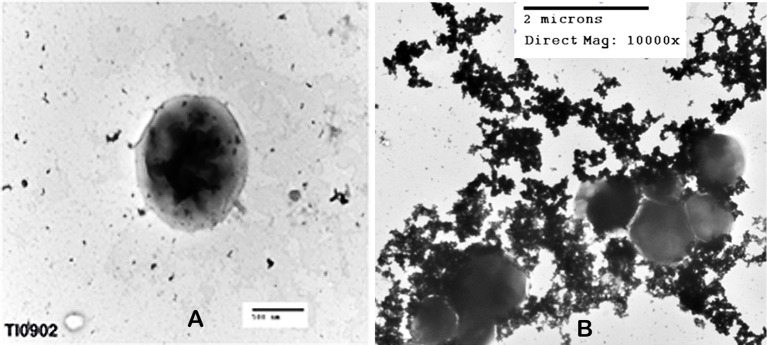
TEM of F. tularensis type A clinical isolate strain TI0902. The bacteria were fixed in glutaraldehyde buffer overnight and stained with 0.5% uranyl acetate. (A) Strain TI0902 following growth in BHI broth with rapid shaking. (B) Strain TI0902 subcultured daily for10 days in CDM broth followed by growth at 32°C for several days on CDM agar, and demonstrating the CLC. Similar CLC material was observed surrounding CDM subcultured type A strain SCHU S4 (not shown). A representative image of the CLC-enhanced O-antigen mutant of strain LVS is shown in Figure 8.